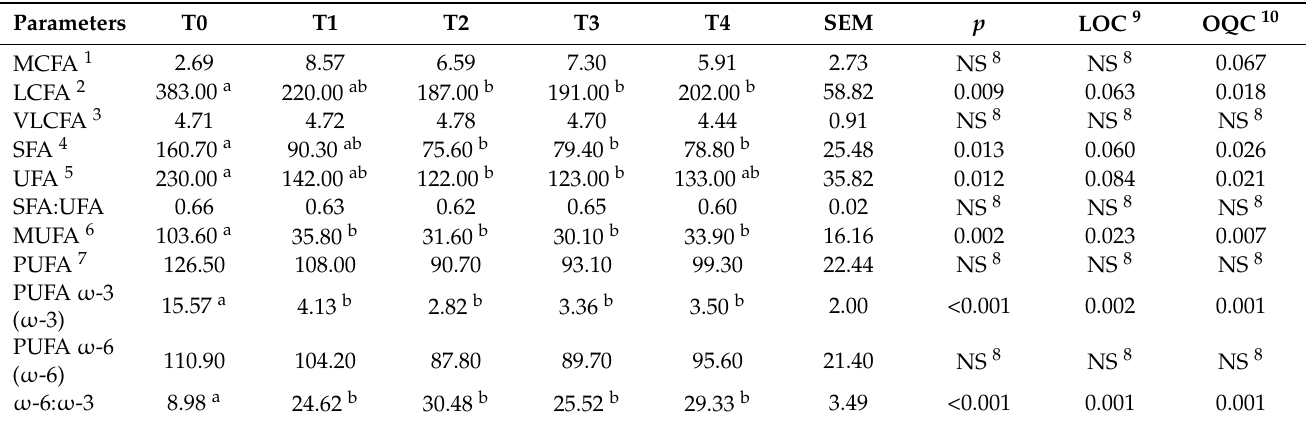
Table 3. Least square means and standard error of the mean (SEM) of plasma fatty acids (mg/dL) according to the length of the chain and the number of double bonds at 15 days before foaling (T0), and 15 (T1), 30 (T2), 60 (T3), and 90 (T4) days after